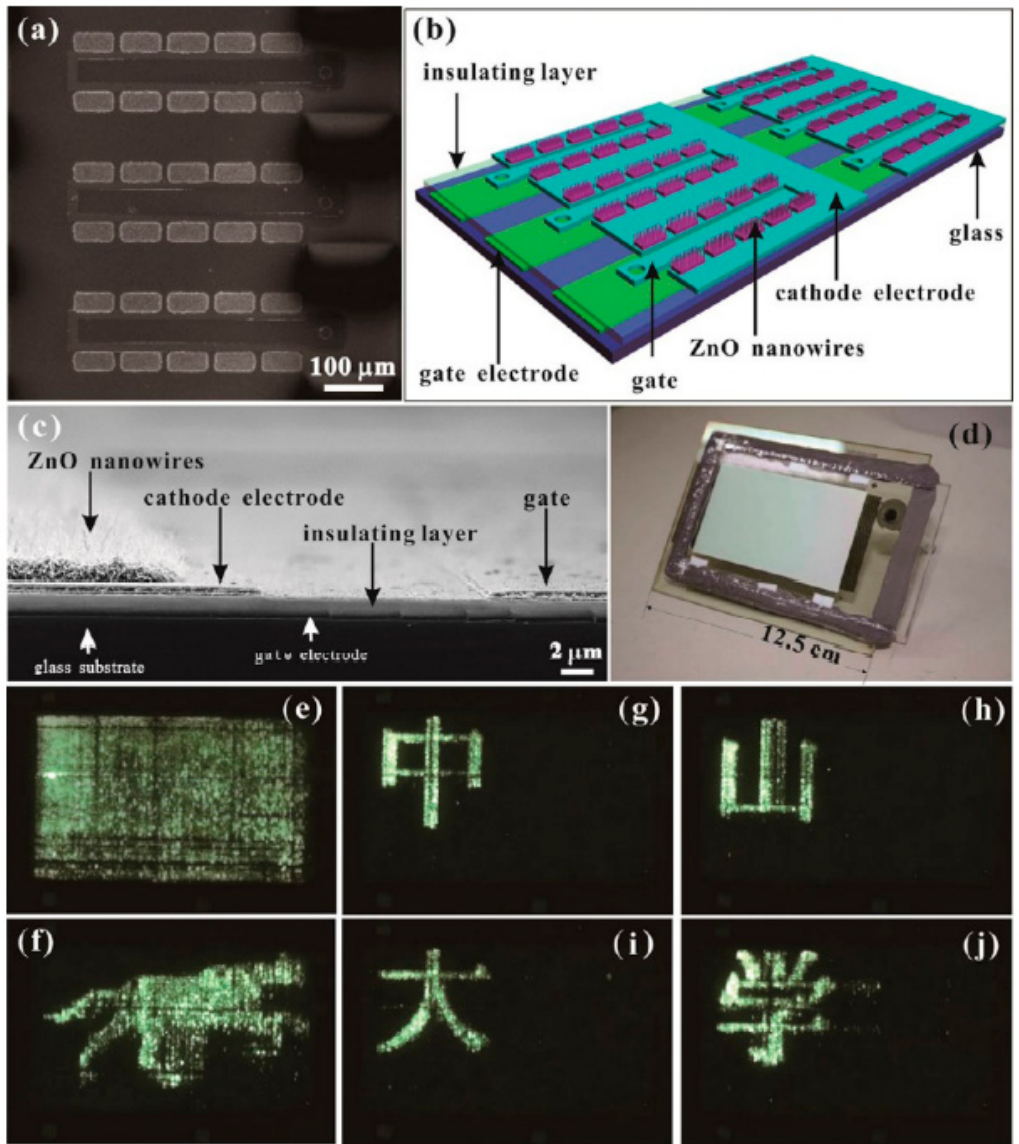
Figure 30. Demonstration of an addressable field emission device based on ZnO nanowires. Top view SEM image ( a ), schematic diagram ( b ), cross-sectional SEM image ( c ) and optical image ( d ) of the device. Full screen ( e ), cartoon of a running dog ( f ) and some Chinese characters ( g – j ) displayed by the device. Reproduced from [35], with the permission of ACS Publications, 2017.